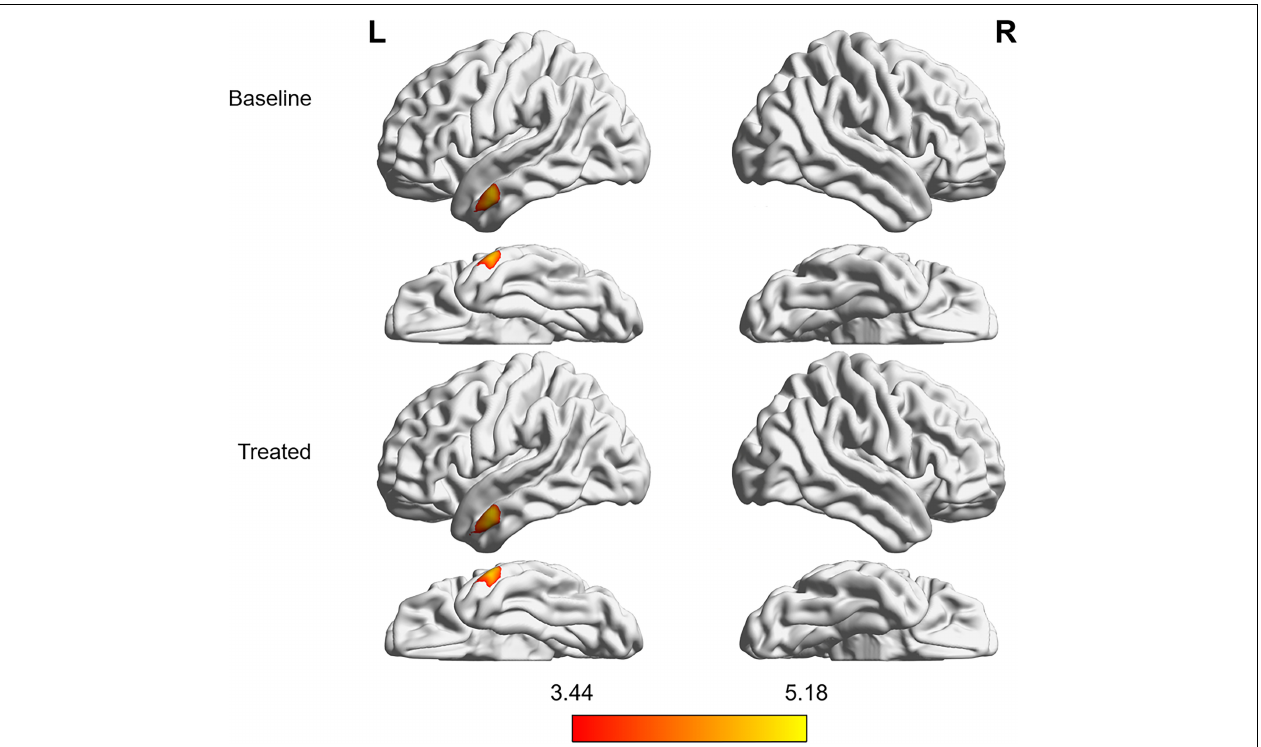
FIGURE 1 | Intergroup differences in GMV between tinnitus patients without HL and HCs before and after sound therapy. At baseline, compared with the HCs, the patients with tinnitus without HL exhibited reduced GMV in the left MTG. After sound therapy (treated), the tinnitus patients continued to show decreased GMV in the same region, and the volume of gray matter was further reduced (corrected at the non-stationary cluster level with FWE P < 0.05). HL, hearing loss, HC, healthy control, MTG, middle temporal gyrus, FWE, family wise error, GMV, gray matter volume. The color bar represents the extent of reduction in GMV.